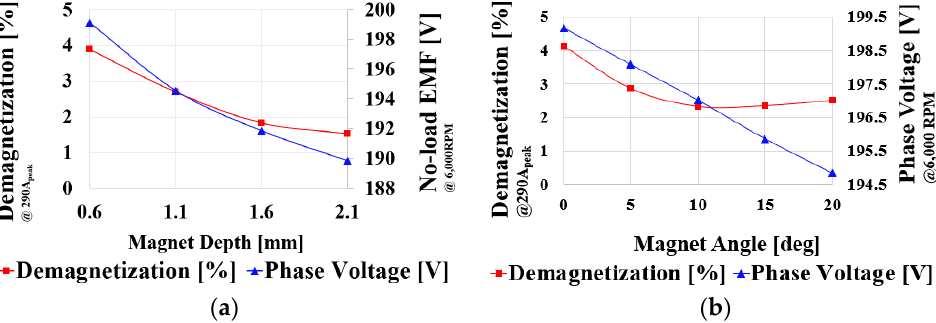
Figure 6. Demagnetization ratio and back EMF depending on the magnet depth and angle ( a ) magnet depth, ( b ) magnet angle.